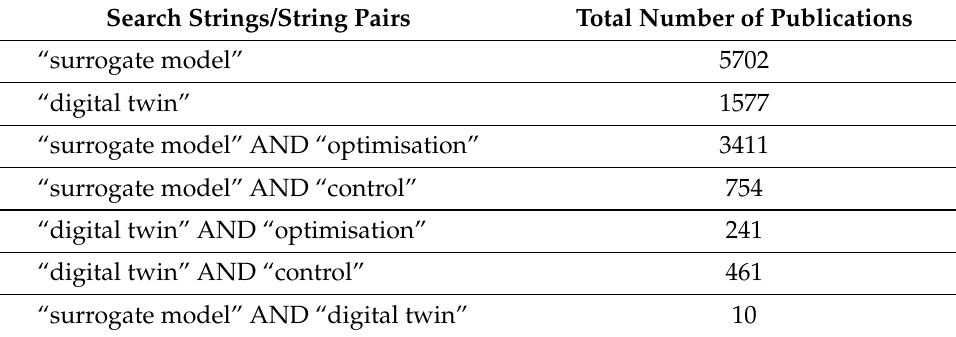
Table 1. Results of publication search in the fields of engineering.